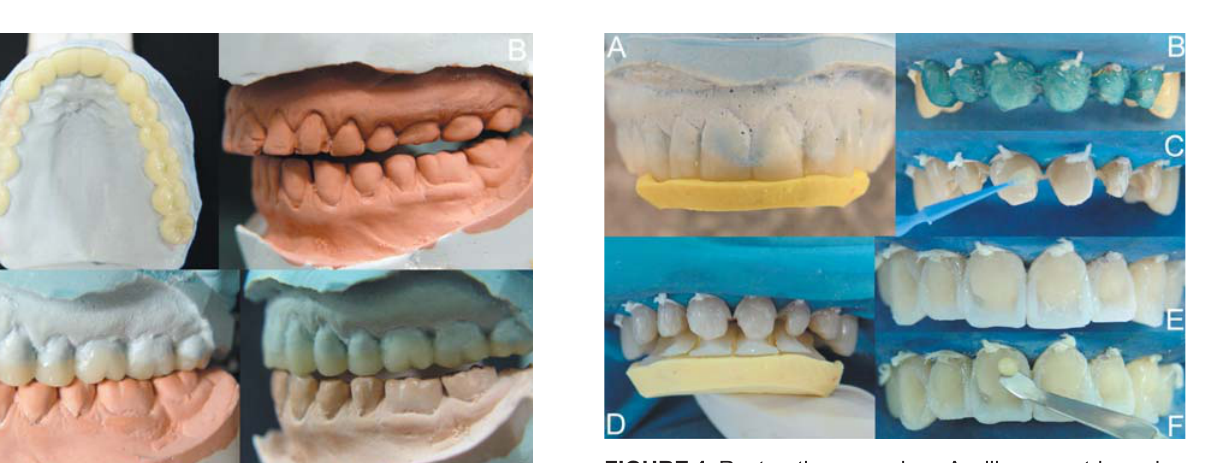
FIGURE 4- Restorative procedure. A: silicone matrix coping waxed areas of anterior teeth; B: acid etching with 35% phosphoric acid; C: adhesive application; D: silicone lingual matrix and construction of palatal tooth surfaces; E,F: composite resin insertion, with enamel and dentin